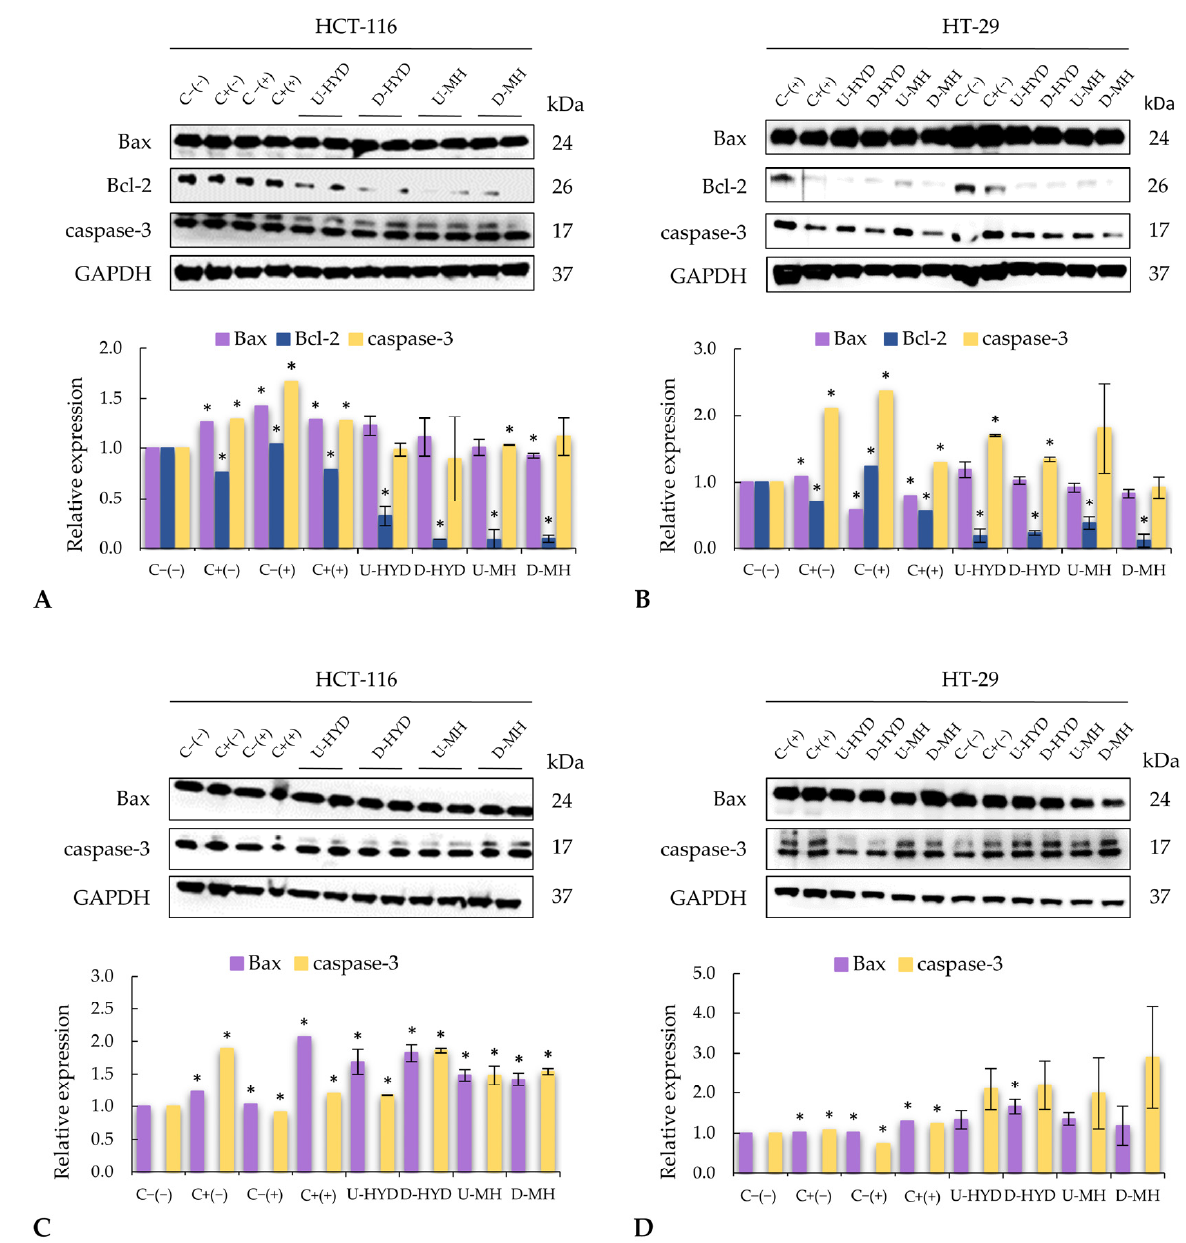
Figure 4. Western blot images and protein relative expression levels of apoptotic proteins in ( A ) HCT-116 and ( B ) HT-29 cells treated with RAW264.7 cells supernatant and western blot images and protein relative expression levels of pro-apoptotic proteins in ( C ) HCT-116 cells and ( D ) HT-29 cells treated with THP-1 supernatant. Each treatment was compared against negative control (C − ( − )). Bars represent means, and error bars represent standard deviations (n = 4). * denotes significant differences (one-way ANOVA, post hoc Duncan’s test, p ≤ 0.05). Abbreviations: colon cancer cells treated with growth media without LPS (C − ( − )); with growth media with LPS (1 µg/mL) (C+( − )); with non-stimulated macrophage supernatant (C − (+)); with LPS-stimulated macrophage supernatant (C+(+)); undigested WB hydrolysate, (U-HYD); digested WB hydrolysate (D-HYD); undigested mousse with WB hydrolysate (U-MH); and undigested mousse with WB hydrolysate (U-MH). Glyceraldehyde 3-phosphate dehydrogenase (GAPDH) was used as housekeeping